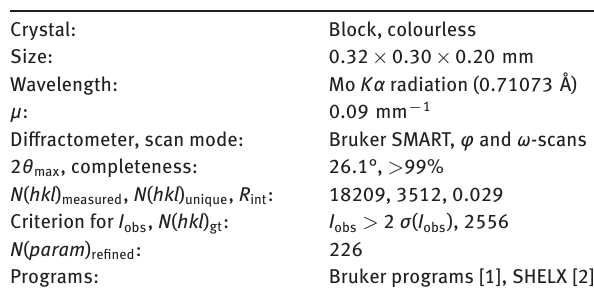
Table 1: Data collection and handling.